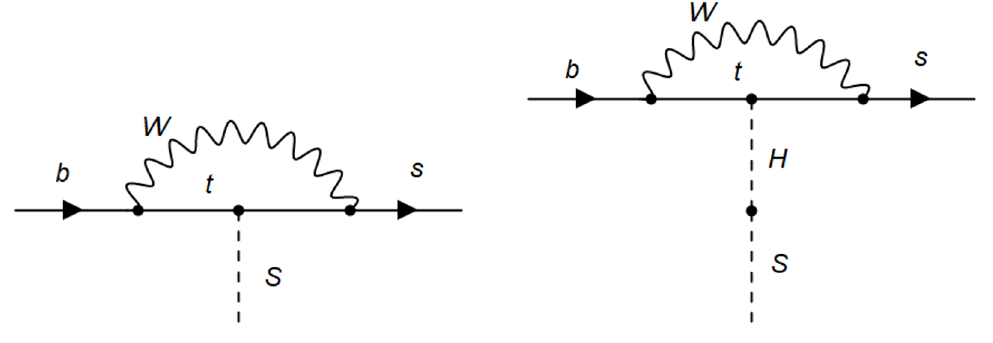
Figure 4 . Feynman diagrams for meson decays into sgoldstino via flavor-conserving sgoldstino couplings [18]: a) diagram of sgoldstino production via Yukawa-type coupling to top-quark; b) diagram with sgoldstino-higgs